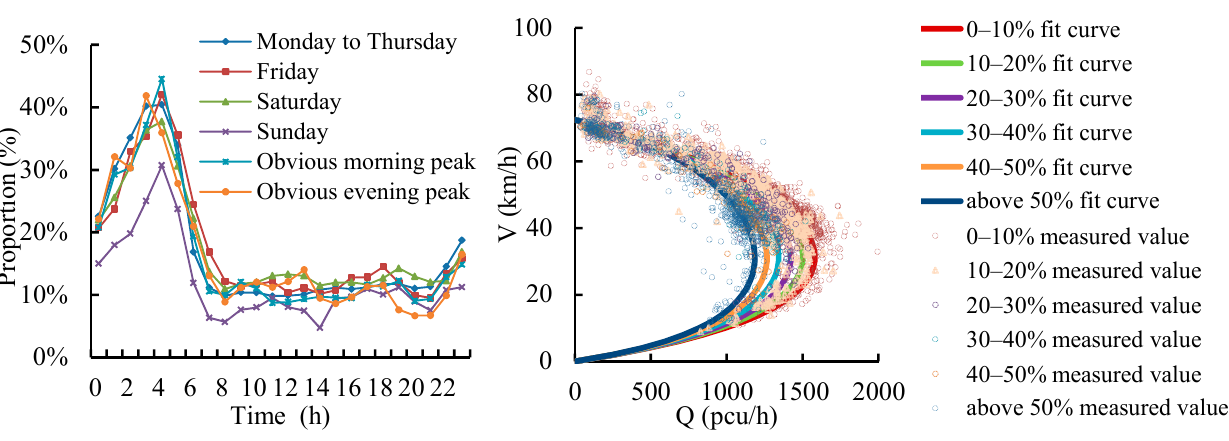
Figure 9. Average speed-flow model under different large-vehicle proportions.